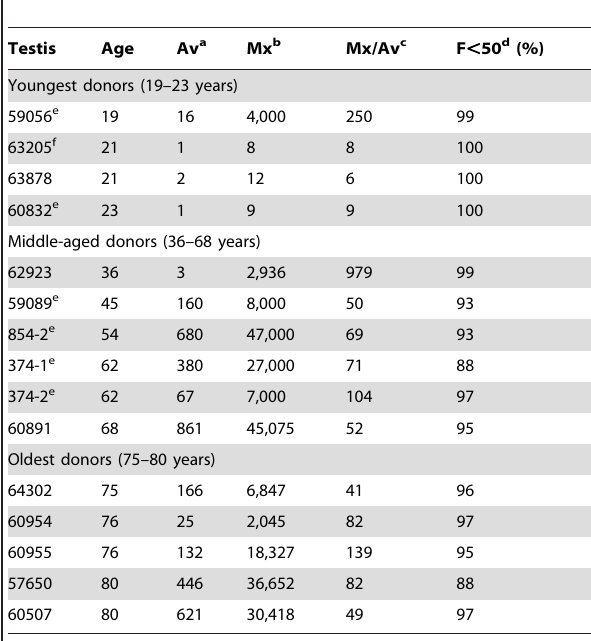
Table 3. Apert syndrome c.755C . G mutation frequency summaries from 15